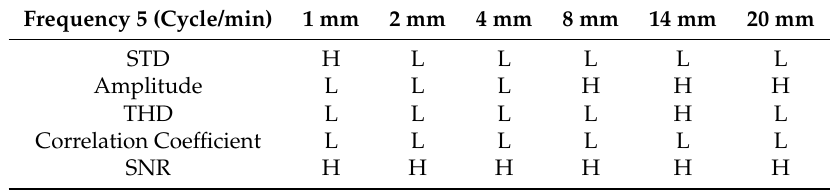
Table A1. Values higher and lower than the median for Frequency of 5 cycles/min for a 2 mm band.